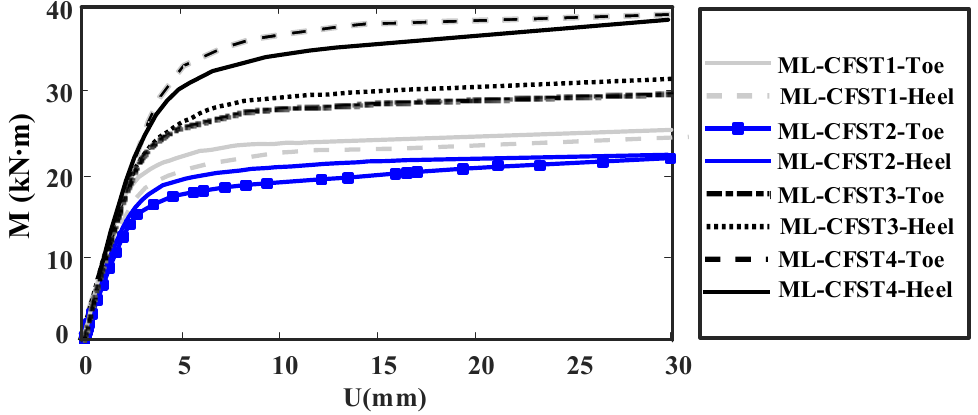
Figure 14. Bending moment (M) versus deflection (U) curves.